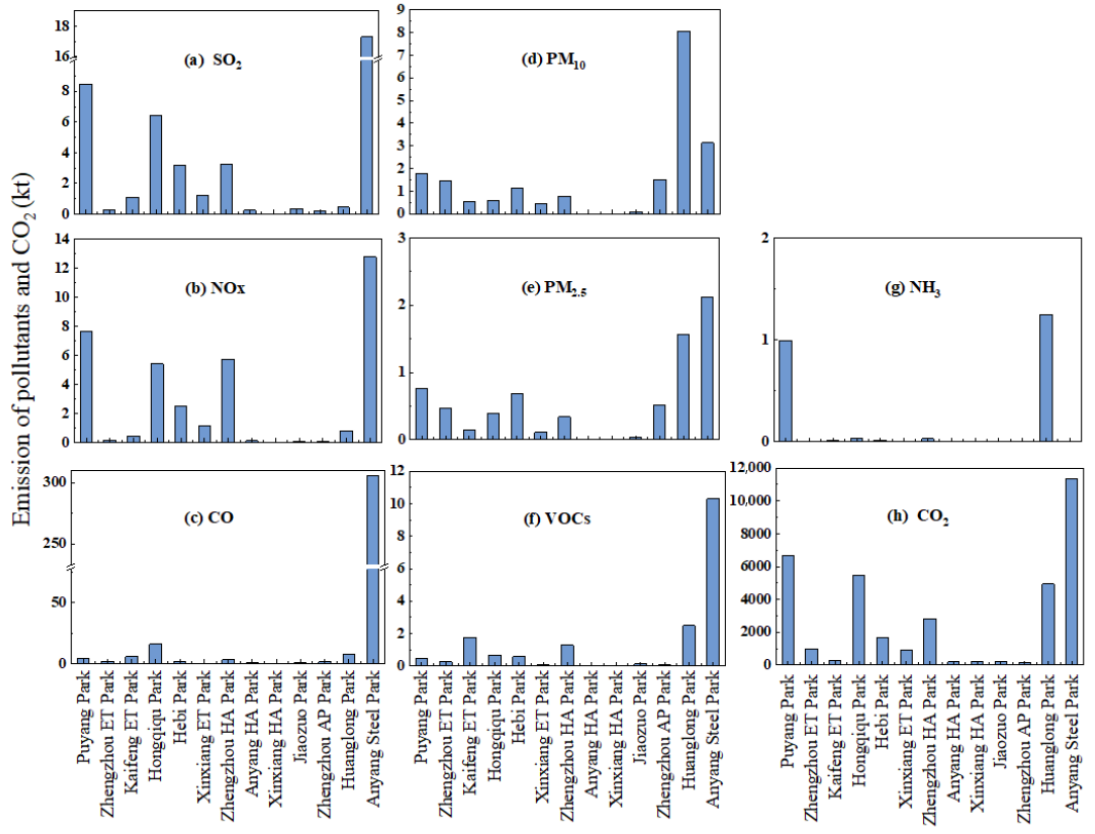
Figure 2. Emissions of air pollutants and CO 2 in industrial